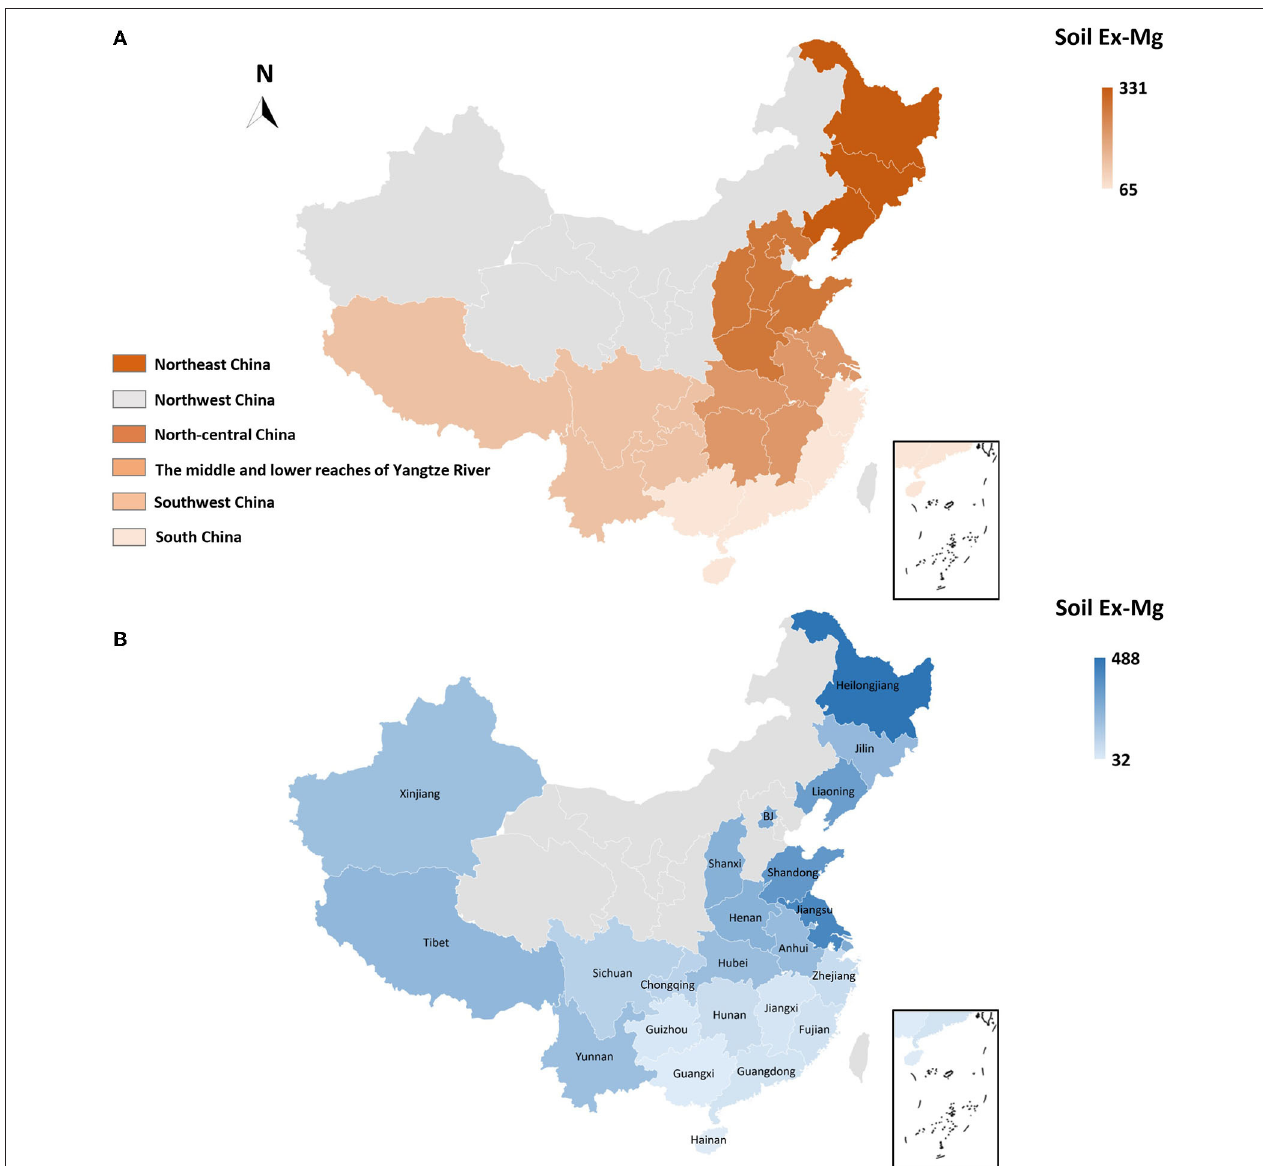
FIGURE 5 | Spatial distribution and magnitude of Mg deficiency in China’s farming system. (A) Spatial distribution of soil Ex-Mg in distinct regions of China, (B) Provincial-level soil Ex-Mg distribution in agricultural soils of China. In China, ∼ 55% of arable lands are Mg-deficient (Ex-Mg < 120mg kg − 1 ), with an obvious spatially declining trend from northern (331mg kg − 1 on average) toward southern (65mg kg − 1 on average) China. Gray color in maps indicated data not